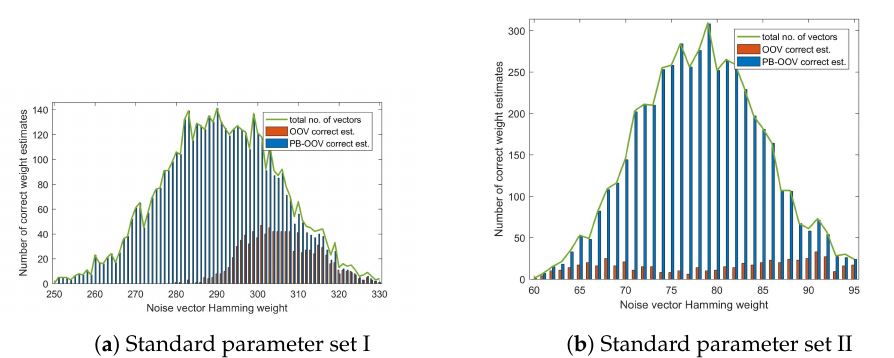
Figure 14. Precision comparison of the weight estimate using the OOV and PB-OOV